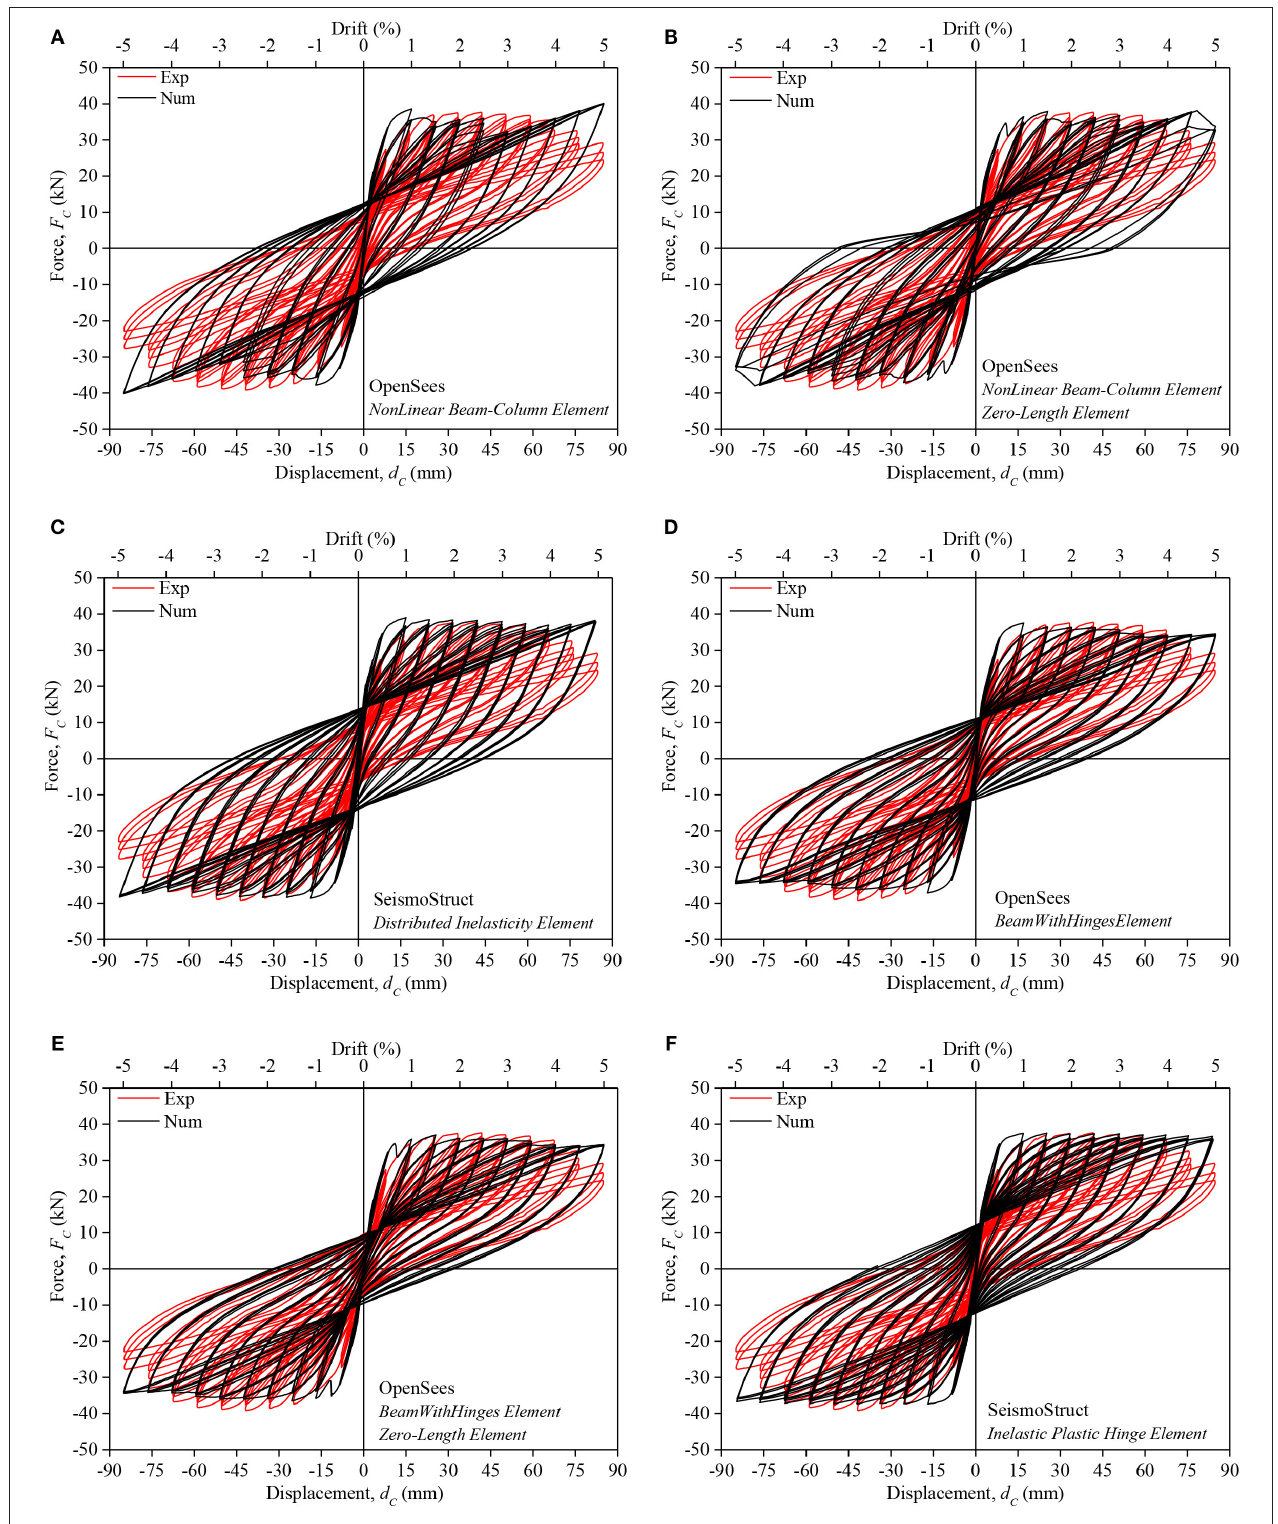
FIGURE 3 | Experimental and numerical force-drift relationship comparison of specimen CPA-3: (A–C) numerical results considering elements with distributed plasticity; (D–F) numerical results considering elements with plastic hinges.